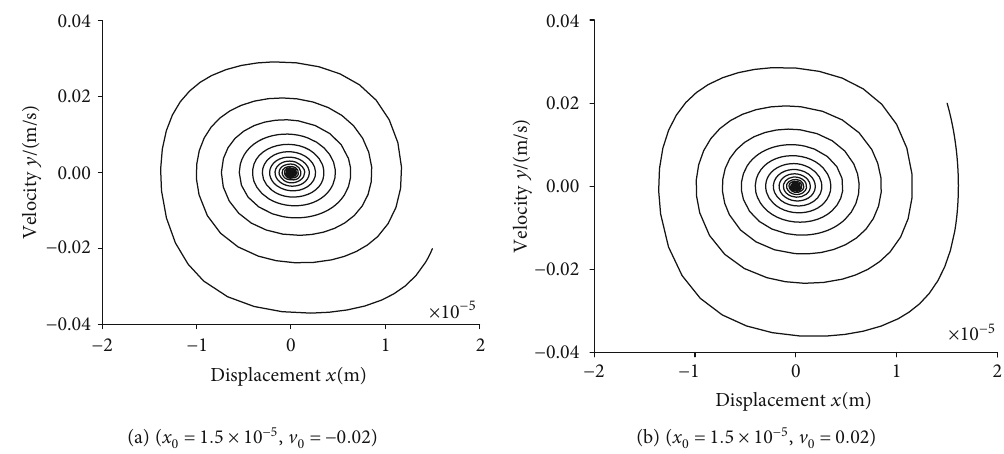
= 1 : 0A , q = 1 × 10 − 4 m 3 /s 0 0